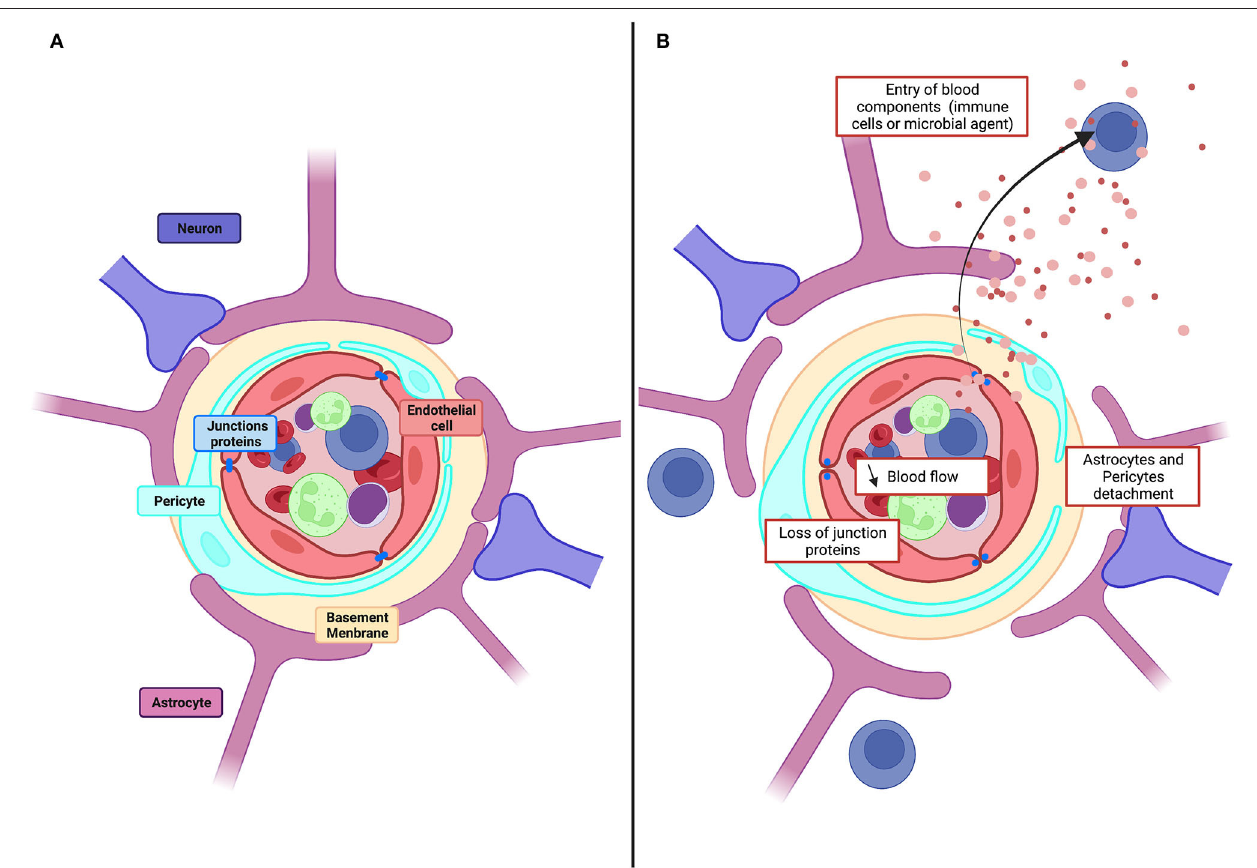
FIGURE 1 | Physiological structure of the BBB and pathological alteration. (A) Schematic illustration of cellular constituents of BBB: the anatomical seat of the BBB is endothelial cells, associated and supported by pericytes and astrocytic end-feet forming the cellular barrier. Endothelial cells are connected to each other by tight junction proteins which ensure the impermeability of the barrier and form a physical barrier. (B) In pathological conditions, the BBB will be affected, and there will be a decrease in blood flow, detachment of pericytes and astrocytes as well as loss of tight junction proteins. All this giving the possibility for toxic molecules to infiltrate the brain